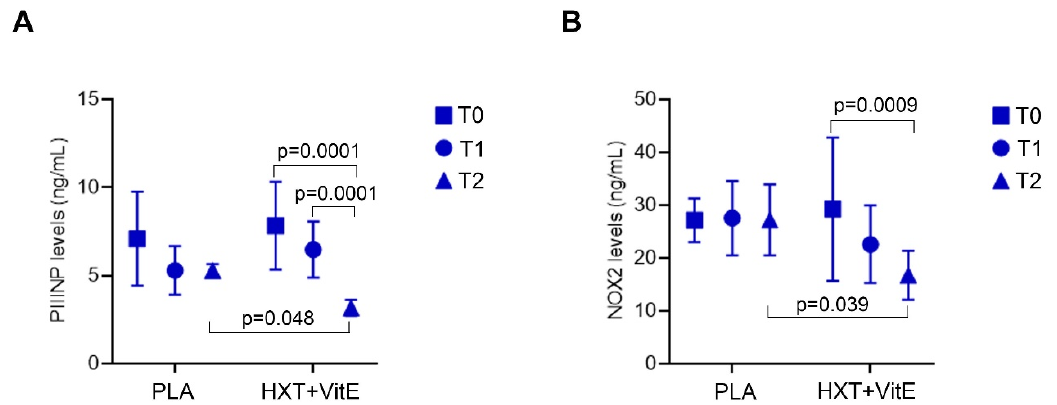
Figure 6 . HXT + VitE treatment reduces the circulating levels of PIIINP and NOX2 in patients with NAFLD-related fibrosis. PIIINP ( A ) and NOX2 ( B ) circulating levels at T0, T1, and T2 in patients belonging to HXT + VitE or PLA group. Values are mean ± SD. The p values for the time-by-group interaction from repeated measures one-way ANOVA are shown.